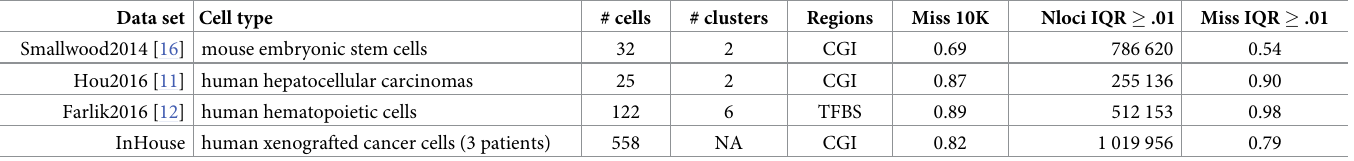
Table 2. Summary of the real data sets used in this work. Column descriptions (in order of appearance) are as follows: (1) data set names corresponding to three pub- lished data sets and the new in-house data set; (2) type of cells in each data set; (3) number of cells considered for each data set, which varied from tens to hundreds of cells; (4) number of clusters, as reported in the respective published papers, NA (not available) for our in-house data set; (5) genomic functional regions considered for each data set, which were the same as in the original papers when applicable, CGI stands for CpG Islands, TFBS stands for Transcription Factor Binding Sites; (6) missing data pro- portion for each data set for the 10,000 loci filtered input and varying from 0.69 to 0.89; (7) number of loci for the largest input data sets obtained by including all regions with methylation IQR � 0.01; these varied from one-quarter million to 1 million CpG sites; (8) missing data proportion for the largest input data sets, which varied from 0.54 to